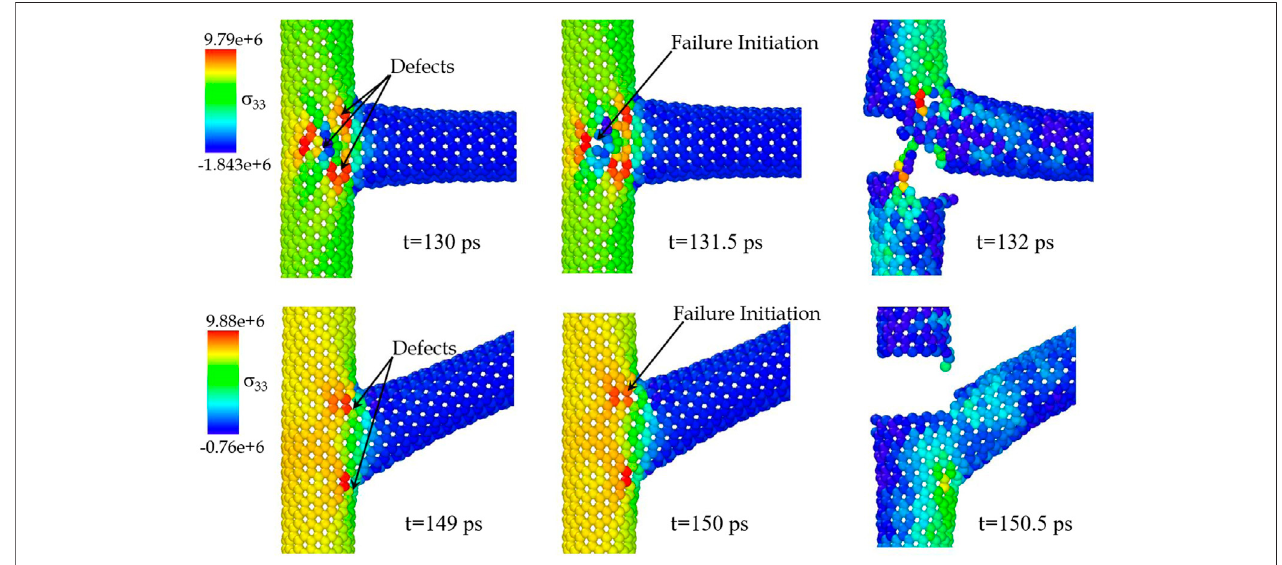
FIGURE 14 | Atomic stresses in 3T-Junction during failure due to uniaxial tensile loading. The color map represents per-atom stress along vertical direction ( σ 33 , bars.Å 3 ) at 1 K temperature.